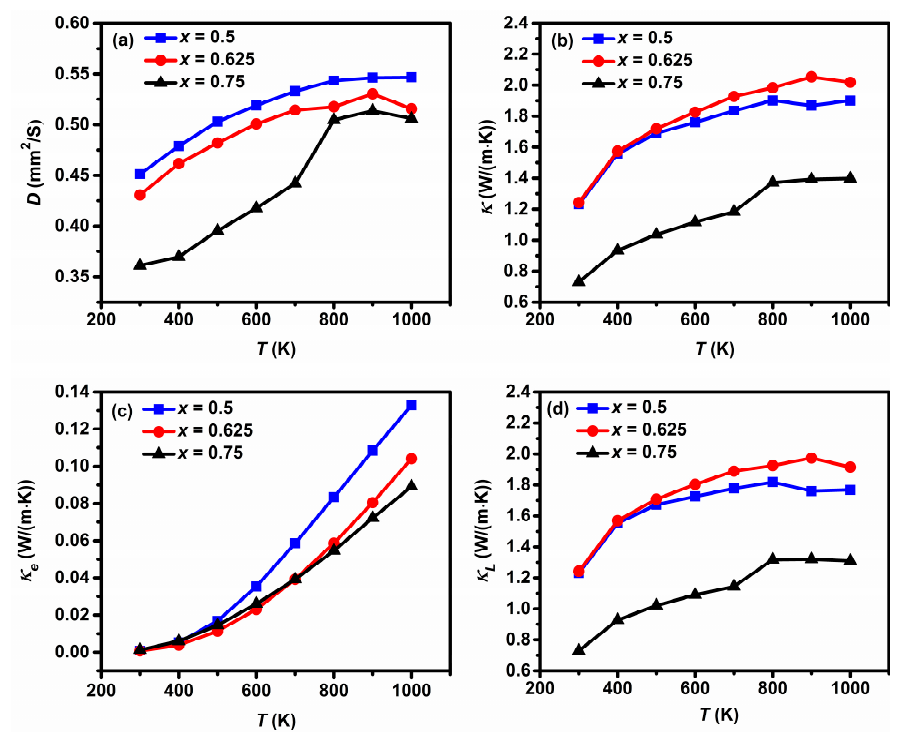
Figure 4. Temperature dependence of ( a ) the thermal di ff usivity, ( b ) the measured thermal conductivity, ( c ) the electronic thermal conductivity, and ( d ) the la tt ice thermal conductivity for